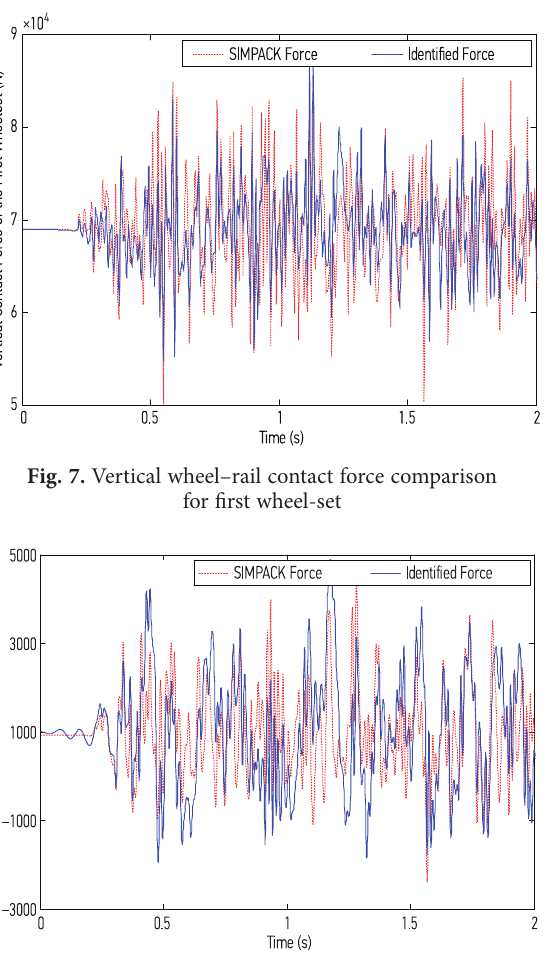
Fig. 9. PSD of vertical (a) and lateral (b) contact force for first